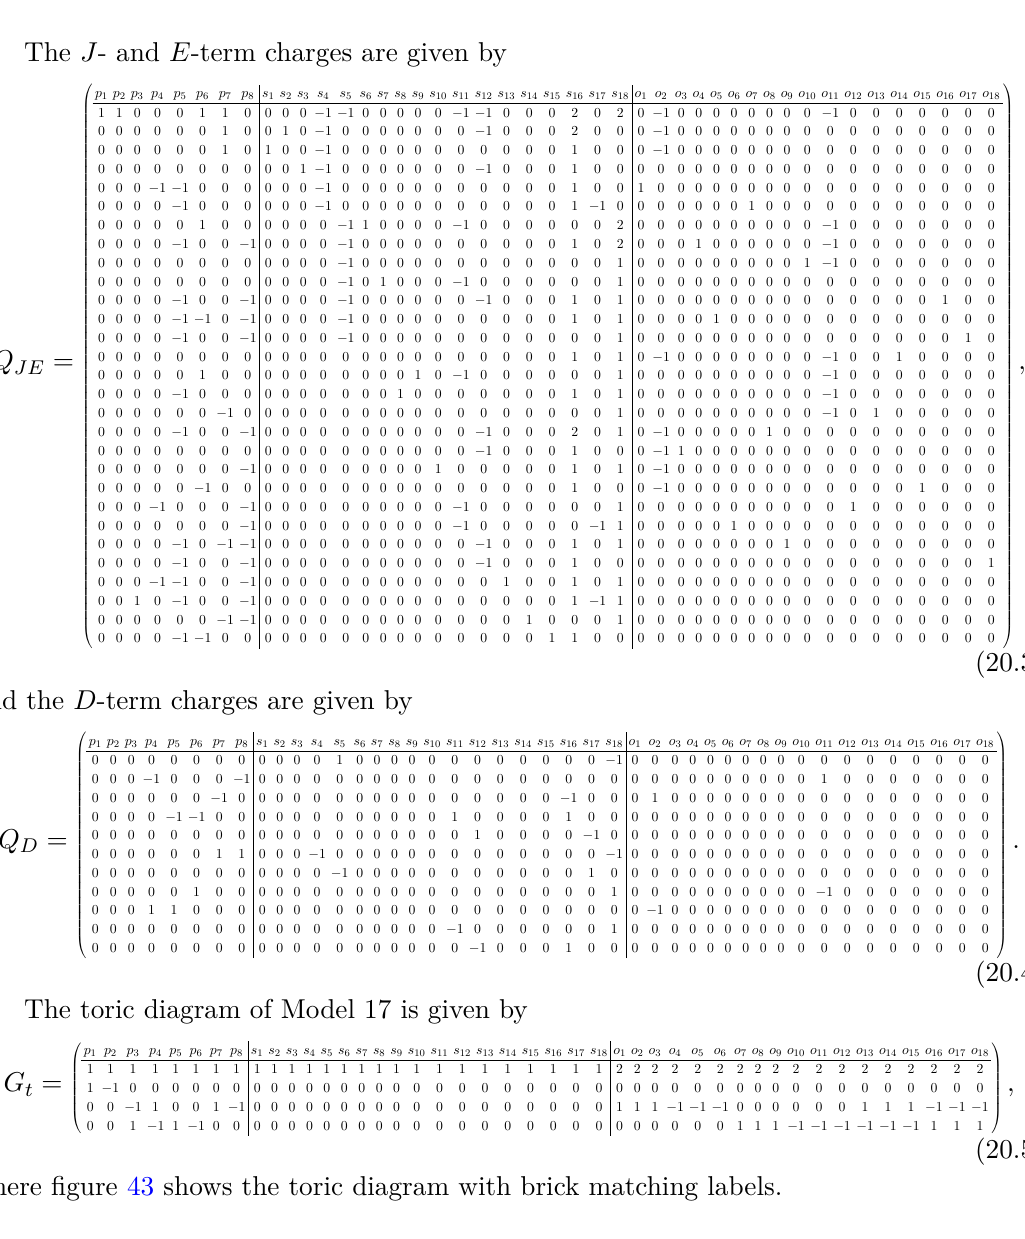
Figure 42 . Quiver for Model